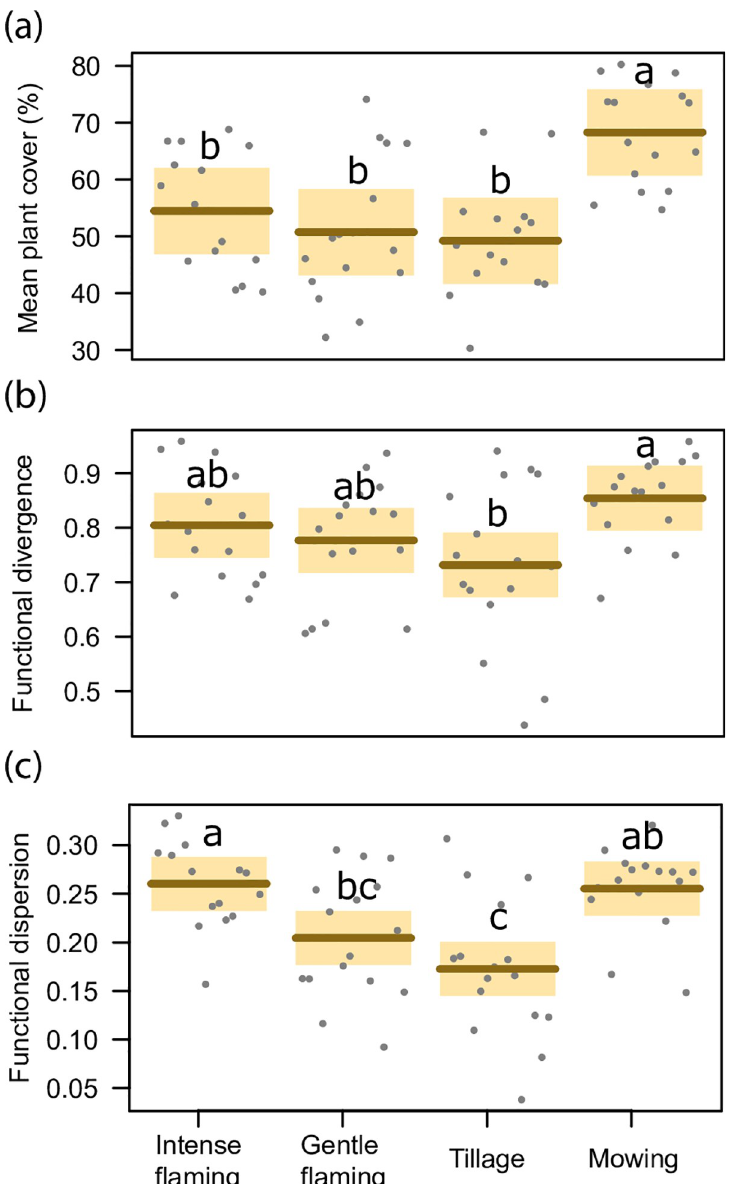
Fig 1. Plant diversity results. Comparison between the different applied weed control techniques (intense and gentle flaming, tillage and mowing), including mean plant cover (Fig 1A), functional divergence (Fig 1B) and functional dispersion (Fig 1C). Different letters show significant differences across treatments (p < 0.05), while shade areas are the confidence intervals (95%).